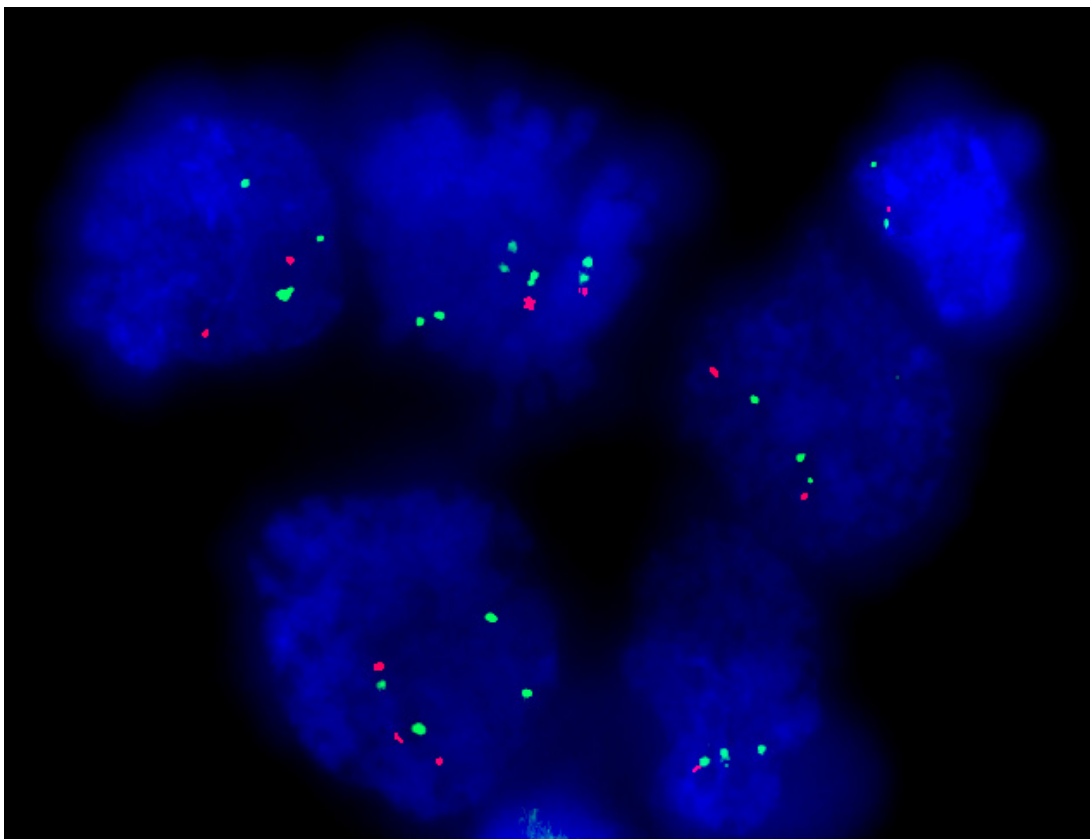
Figure 1. Example of 1p/19q FISH results from patient P5 showing an imbalance between number of copies of chromosome 1p on cells in touch preparation slides (1x 1000 magnification). FISH performed with the LSI 1p36 Spectrum Orange probe (red signals) and the control part LSI 1q25 Spectrum Green probe (green signals).